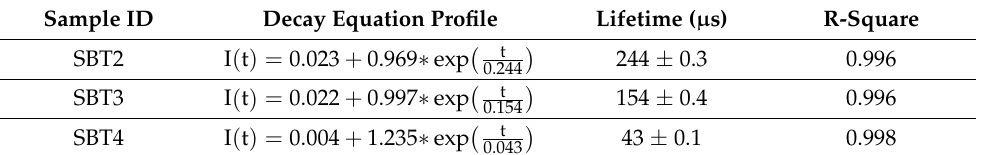
Table 4. Lifetime decay equation, lifetime, and R-square of the